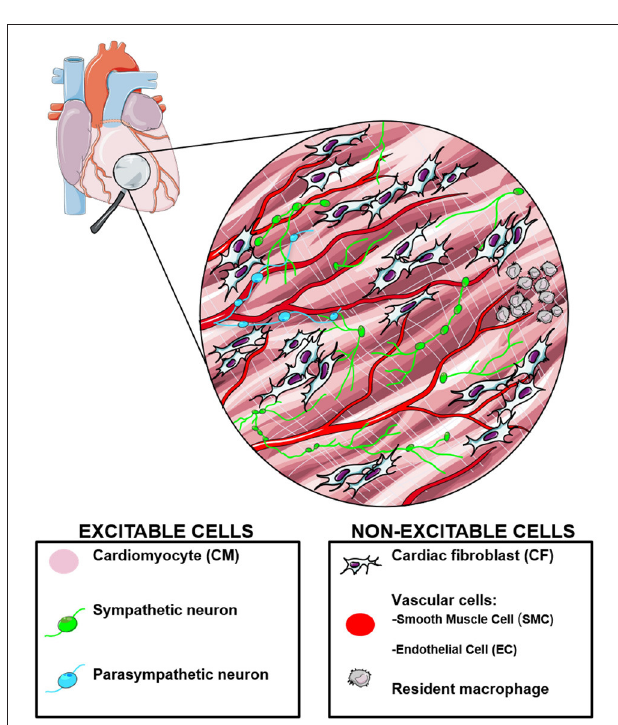
FIGURE 4 | The heart is a multicellular network of excitable and non-excitable cells, which have been targeted with various opsins for optogenetic investigation. Modified from Zaglia et al.